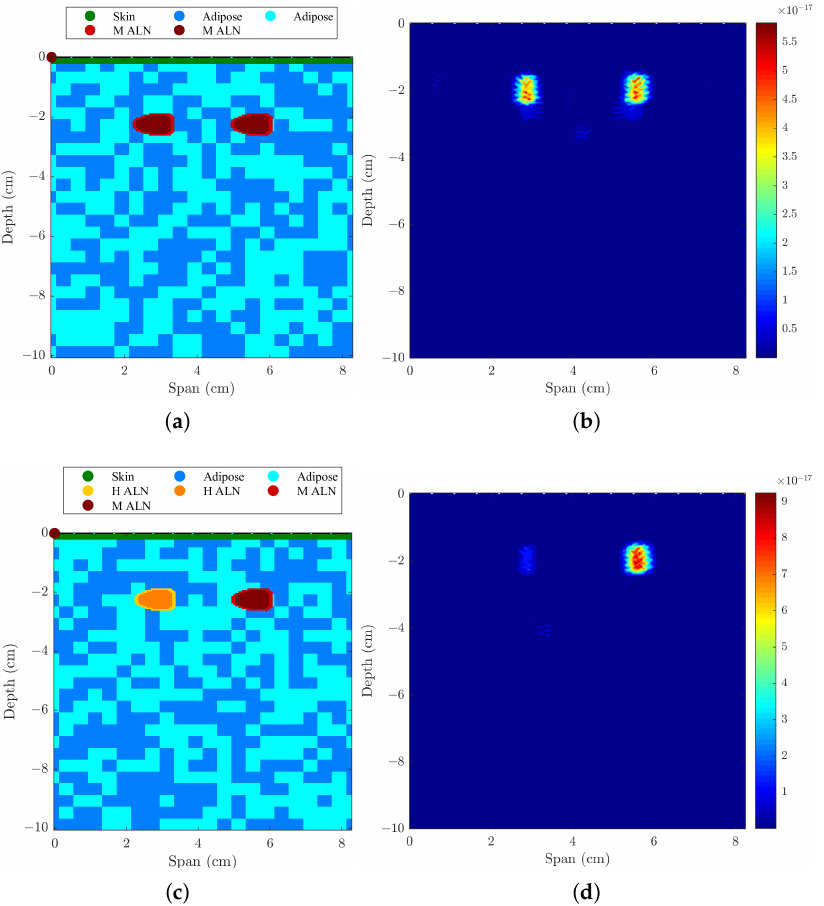
Figure 7. Models and corresponding backscattered energy results from the implemented MWI system of an axillary region model with ( a , b ) two metastasized (M ALN) ALNs, and ( c , d ) one healthy (H ALN) and one metastasized ALN, separated by 15 mm. The figure shows the simulated models in ( a , c ), and the corresponding backscattered energy results using the CR-DMAS beamformer after applying Bond’s artifact removal algorithm in ( b , d ). The high intensity regions in ( b , d ) indicate the detection of the lymph